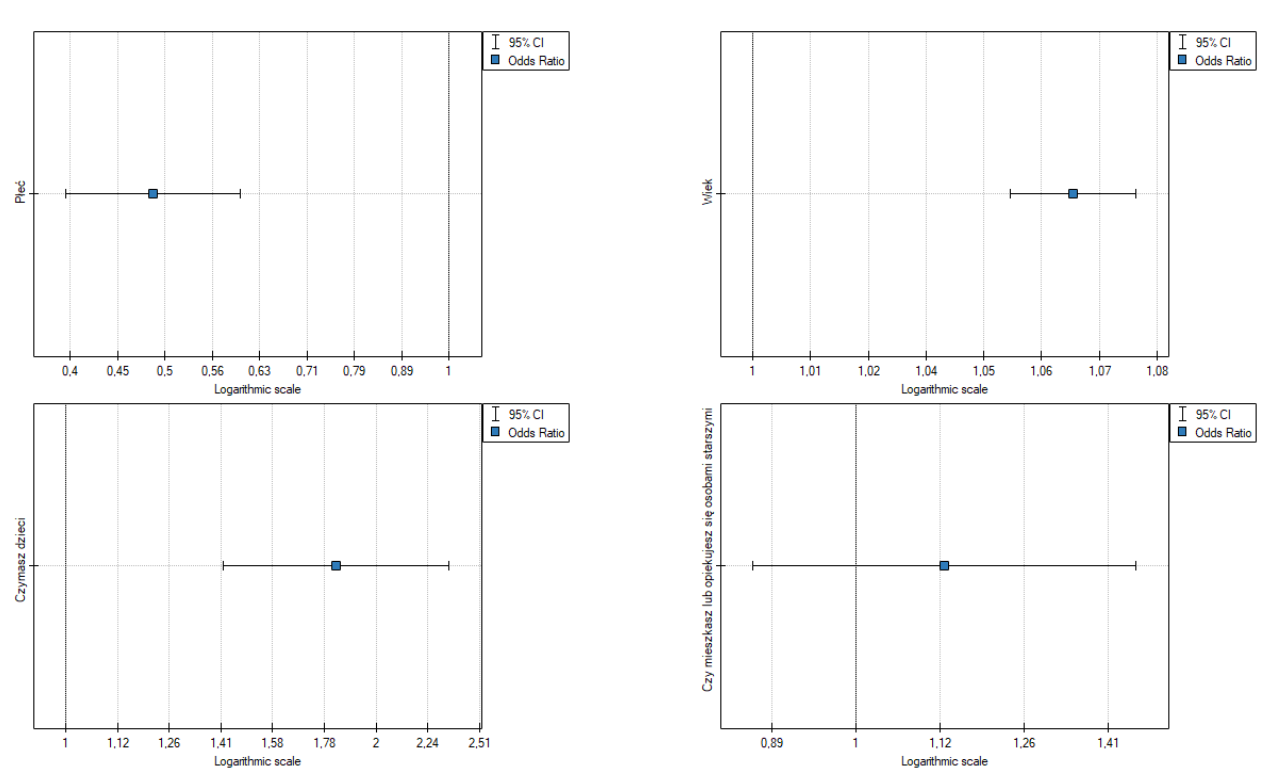
Figure 3. Odds ratios for psychological (mental) symptoms of fear and demographics. Source: own study based on research.